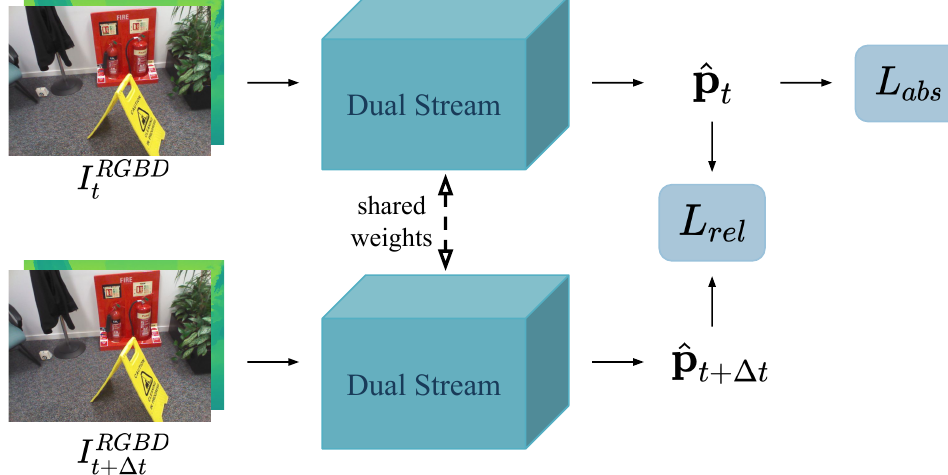
Figure 3. Training flow of proposed